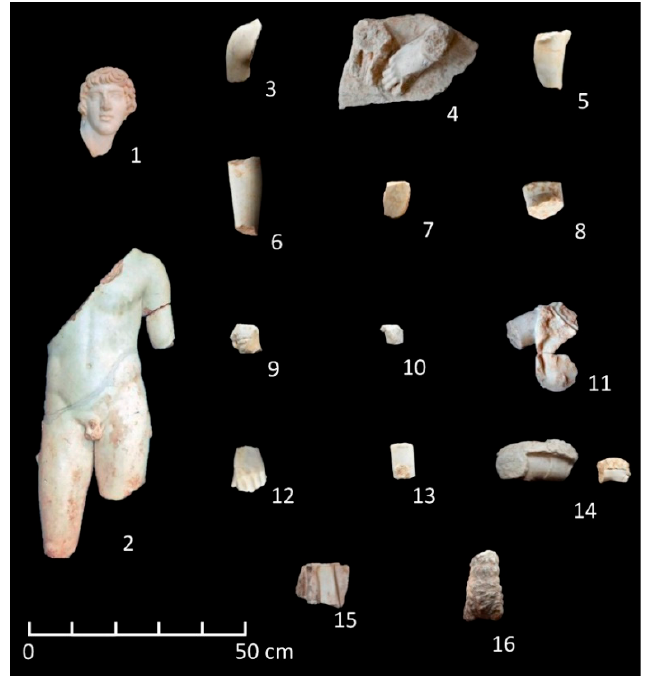
Figure 1. The sixteen sampled marble fragments retrieved from the “Els Munts” Roman villa.